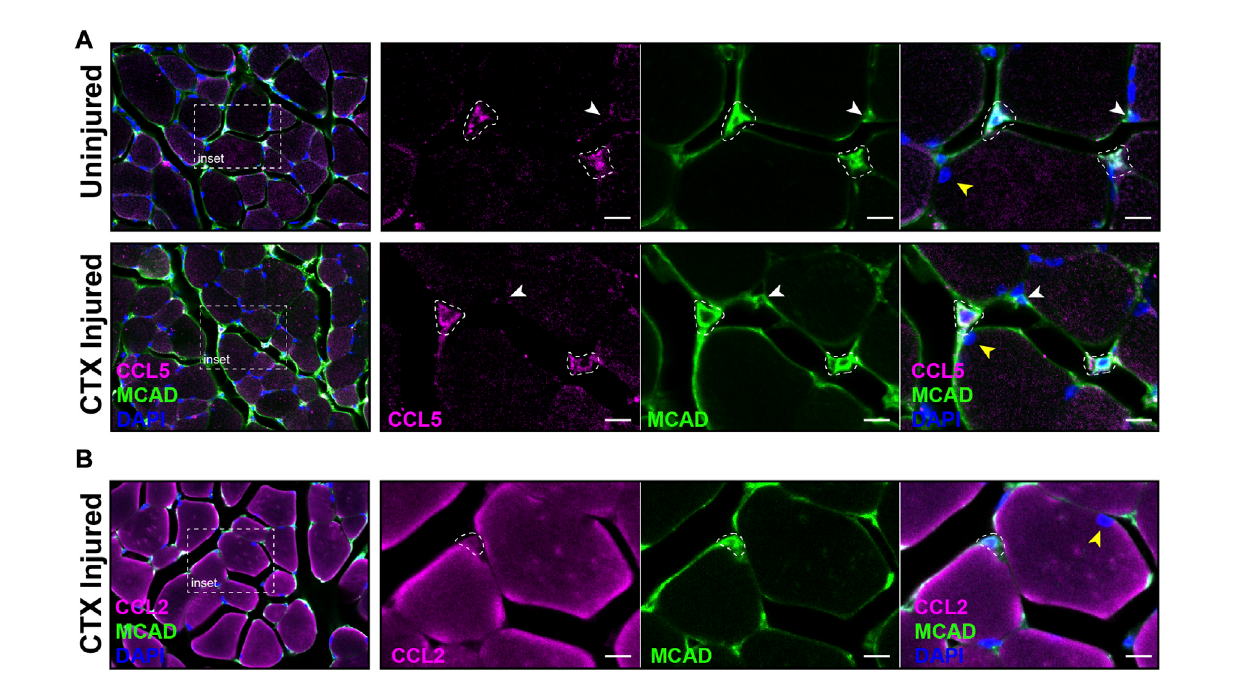
FIGURE 9 Co-expression of CCL2, CCL5 and MCAD in CTX-injured skeletal muscle. (A) The expression of CCL5 (magenta) and MCAD (green) were visualized in DAPI-labeled (blue) CTX-injured and uninjured quadriceps at 3 DPI by IF. White dotted outlines mark CCL5/MCAD co-expressing satellite cells, the whitearrowheadindicatesaMCAD-onlyexpressingsatellitecell,andtheyellowarrowheadmarksamuscle fi bernucleus. (B) CCL2(magenta)andMCAD (green) co-expressing satellite cells (white dotted outline) were detected in CTX-injured quadriceps at 1 DPI. The nuclei were labeled with DAPI (blue). In contrast to CCL5, signi fi cant expression of CCL2 was detected in muscle fi bers. The yellow arrowhead denotes a muscle fi ber nucleus. Scalebar = 10